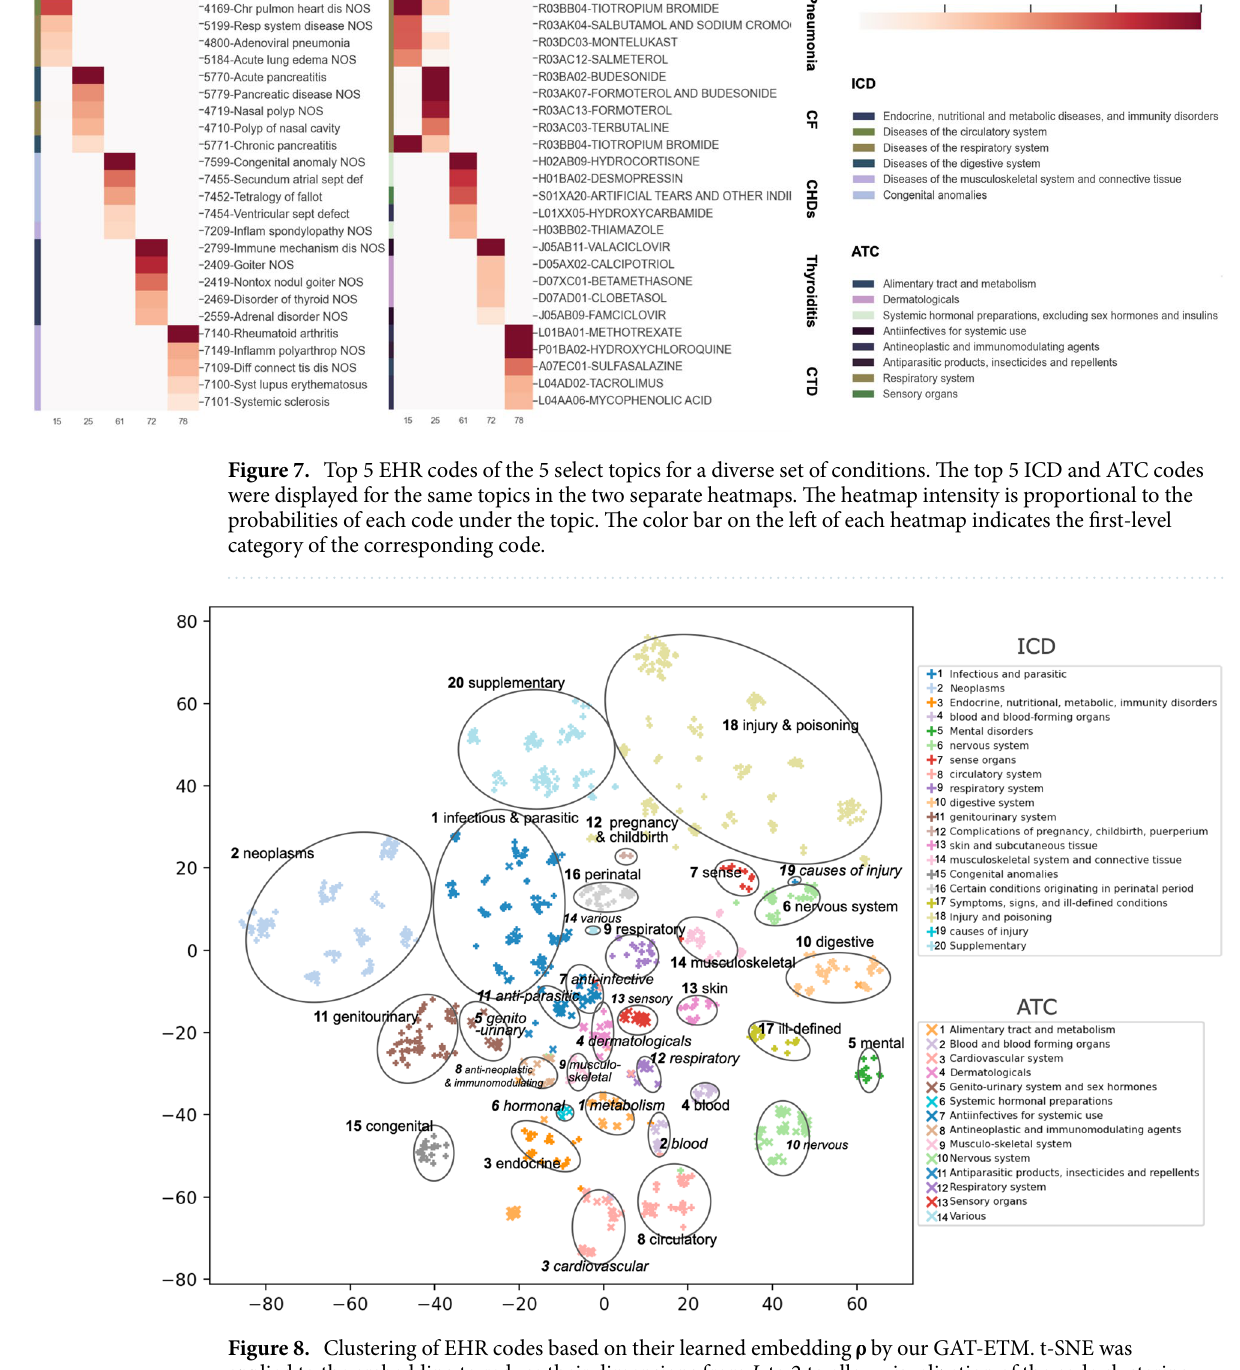
Figure 8. Clustering of EHR codes based on their learned embedding ρ by our GAT-ETM. t-SNE was applied to the embedding to reduce their dimensions from L to 2 to allow visualization of the code clustering. As shown in the legend, shape + and × indicate ICD and ATC code, respectively; colors indicate different high-level categories. Aligned ICD and ATC categories are assigned identical or similar colors. Within ICD/ ATC vocabularies, nodes of the same category are grouped together. Each group was circled and labeled with abbreviations. ICD and ATC group names are shown in regular and italic fonts,